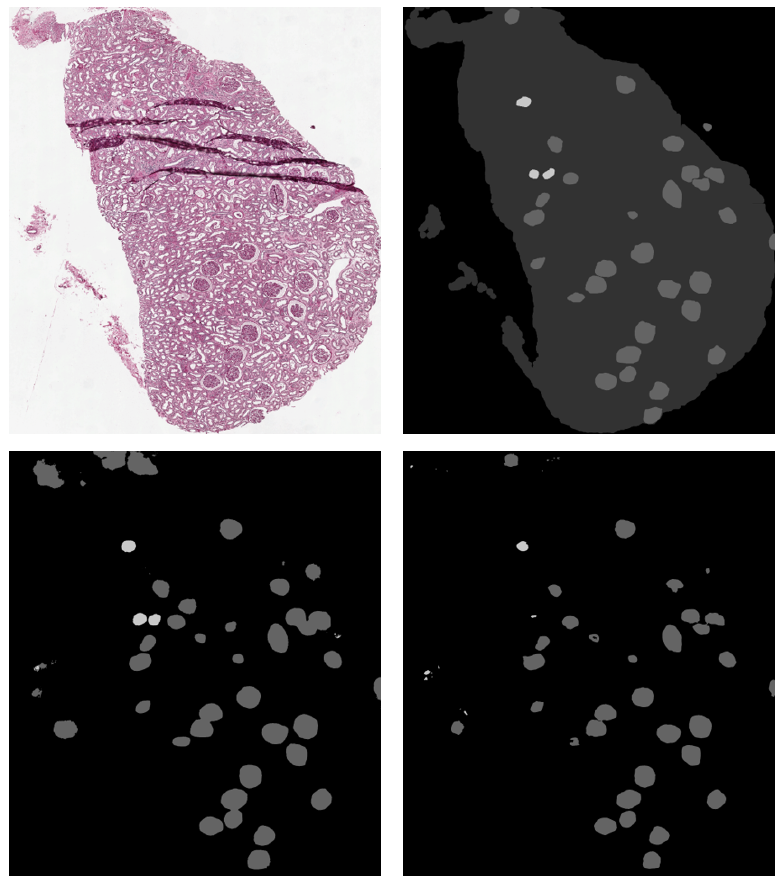
Figure 9. Top Left: original image. Top Right: ground truth. Bottom Left: SegNet prediction. Bottom Right: DeepLab v3+ prediction. Sclerotic glomeruli and non-sclerotic ones are white and gray colored,